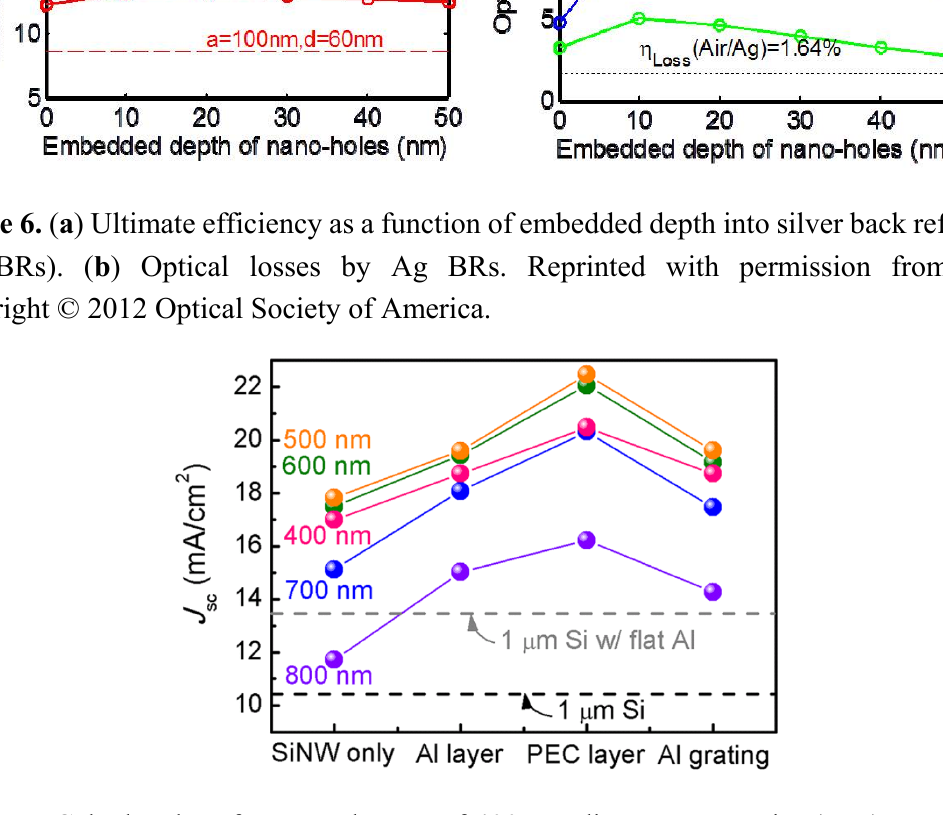
Figure 7. Calculated J sc for several types of 400-nm-diameter nanowire (NW) arrays with various periods (400–800 nm). Gray and black dashed lines indicate J sc of the 1- μ m-thick Si with and without the flat Al underlayer, respectively. Reprinted with permission from